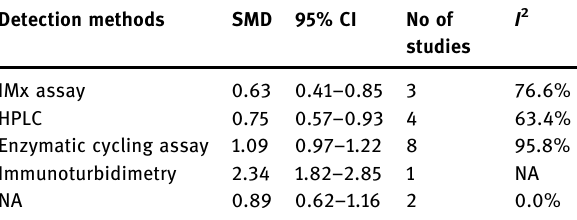
Table 2: Sub - group analysis for serum Hcy between UC and healthy controls Detection methods